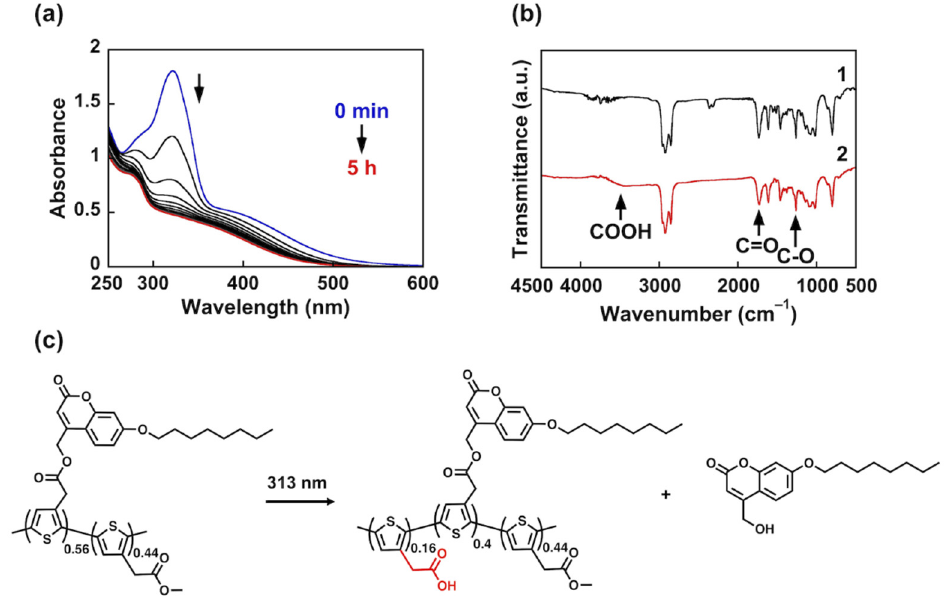
Figure 2. ( a ) Changes in the absorption spectra of PC 56 T 44 upon irradiation at 313 nm in THF. (b) FT- IR spectra of PC 56 T 44 ( 1 ) before and ( 2 ) after irradiation at 313 nm for 5 h. ( c ) Schematic showing the photocleavage of PC 56 T 44 .